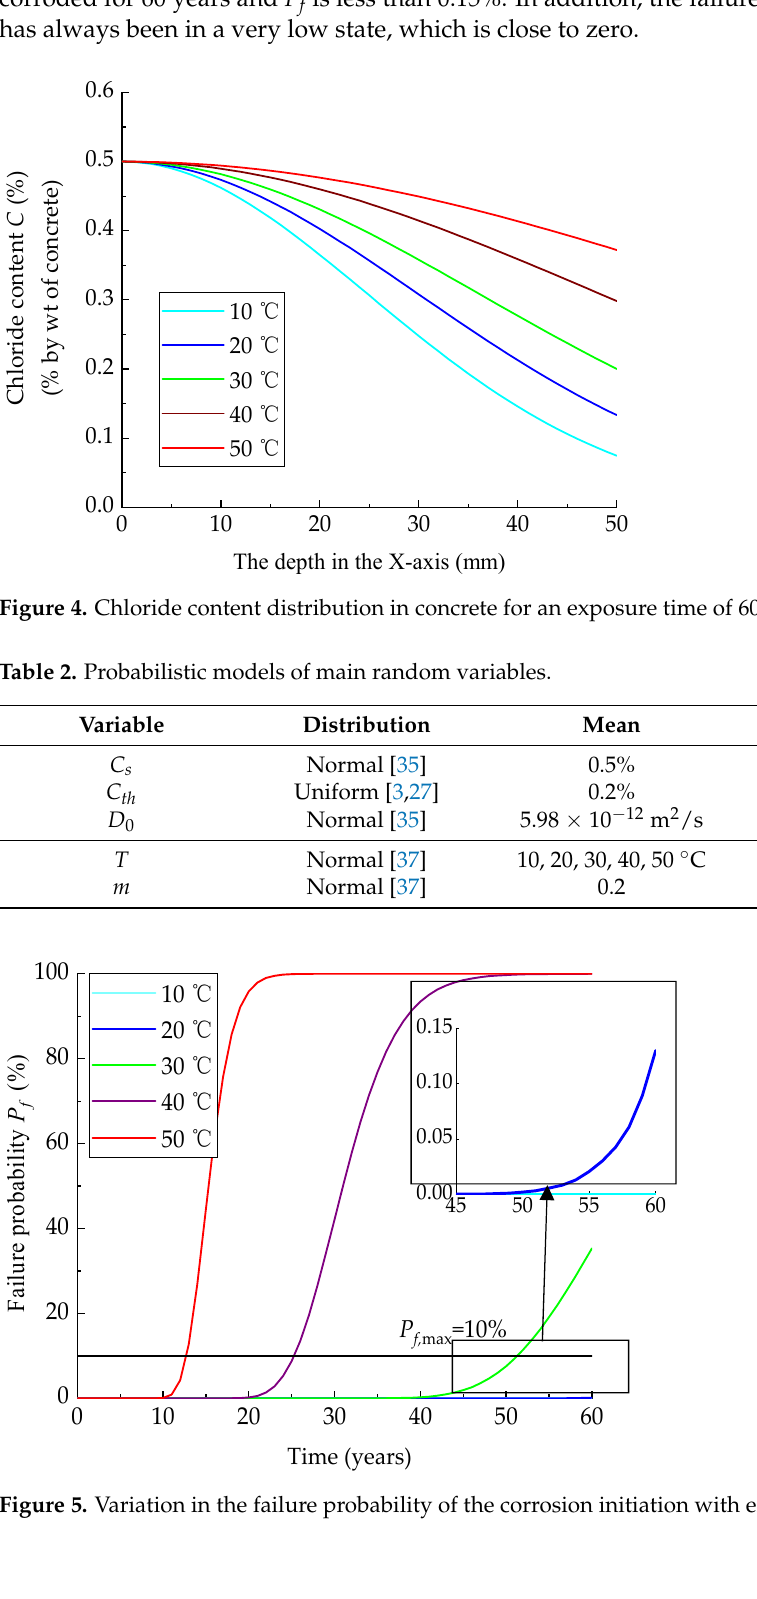
Figure 3. Relation between chloride content ( C ) at the steel surface and exposure time ( t ).